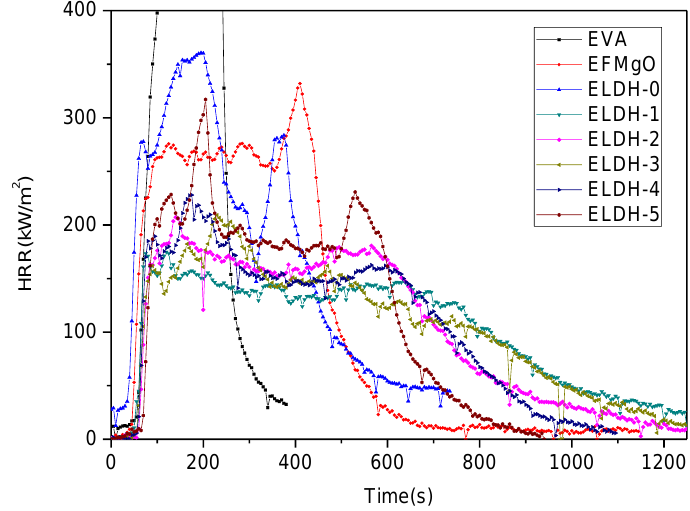
Figure 2. HRR curves of all EVA/LDHs composites. Table 2. Data from cone calorimeter test.